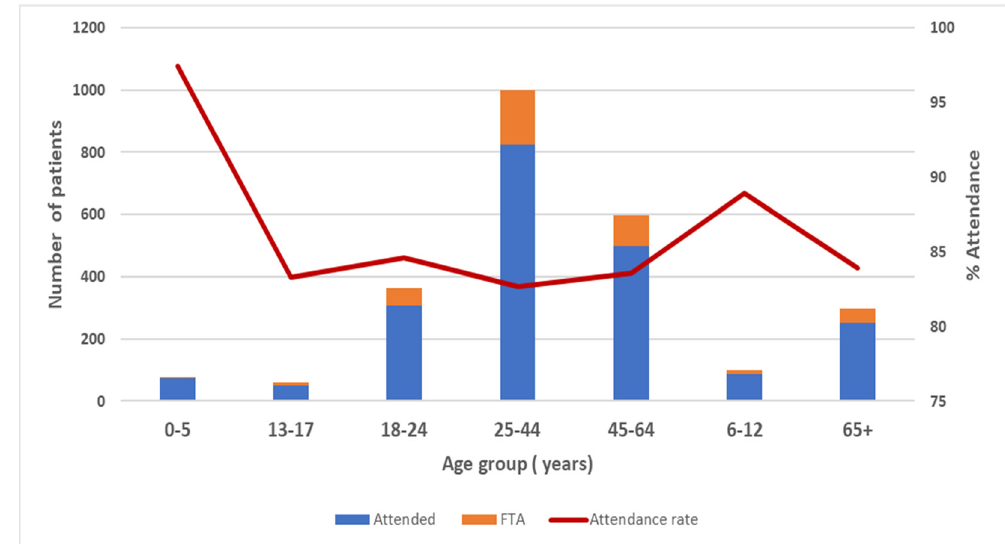
Figure 4. Teledentistry attendance and failure-to-attend (FTA) rates by age group. Table 1. Client demographics for RDHM telehealth appointments (attended/FTA) between 1 May